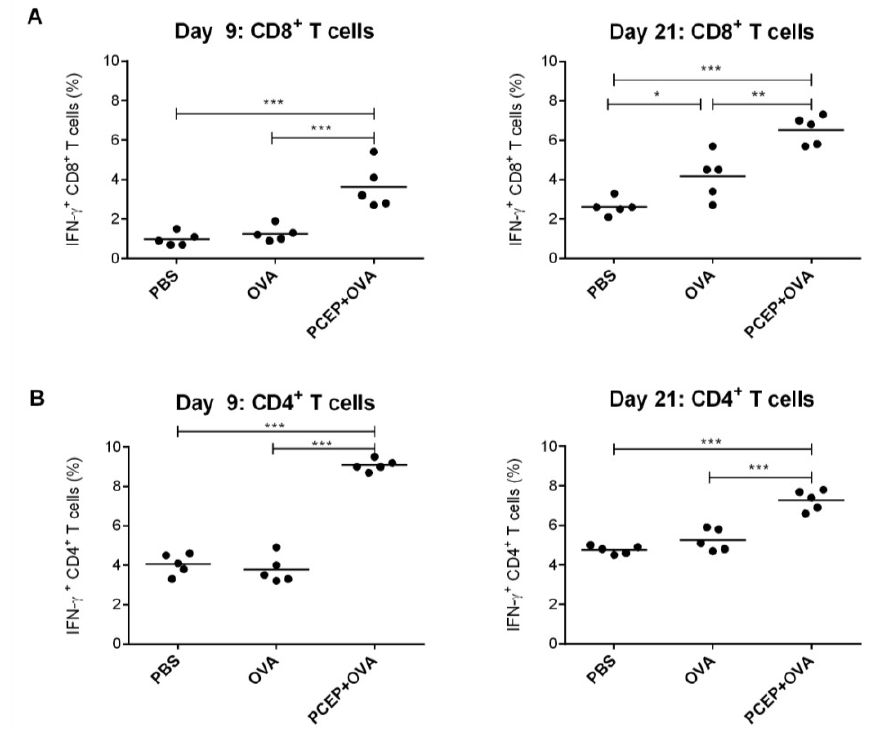
Figure 5. PCEP induces antigen-specific IFN-γ production in CD4 + and CD8 + T-cells. BALB/c mice were immunized i.m. with 25 μL each of either phosphate-buffered saline (PBS) as a control, 10 µg ovalbumin (OVA) or 50 μg of PCEP co-delivered with 10 μg OVA. Booster immunization was given on Day 14 to half of the mice in each group. Mice were euthanized on Days 9 and 21 after the first immunization to collect spleens. Splenocytes (1 × 10 6 cells) were restimulated with OVA (10 μg/mL) in culture for 12 h. Intracellular production of IFN-γ by CD8 + ( A ) and CD4 + ( B ) T-cells was analyzed by flow cytometry. Statistical analysis was done by one-way ANOVA, and the differences between the treatments were compared by Tukey’s multiple-comparison test; *** p < 0.0001, ** p < 0.001, * p <